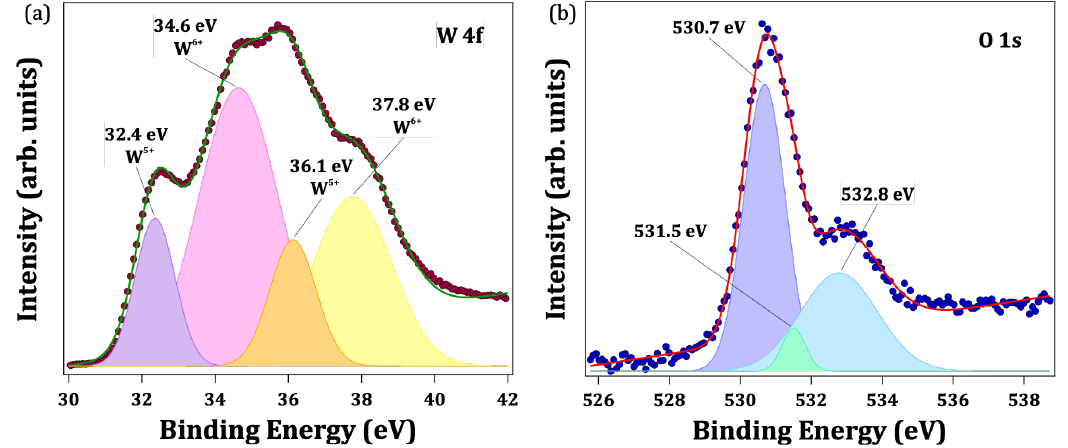
Figure 6. Fitted XPS core levels spectra of ( a ) W 4f and ( b ) O 1s.